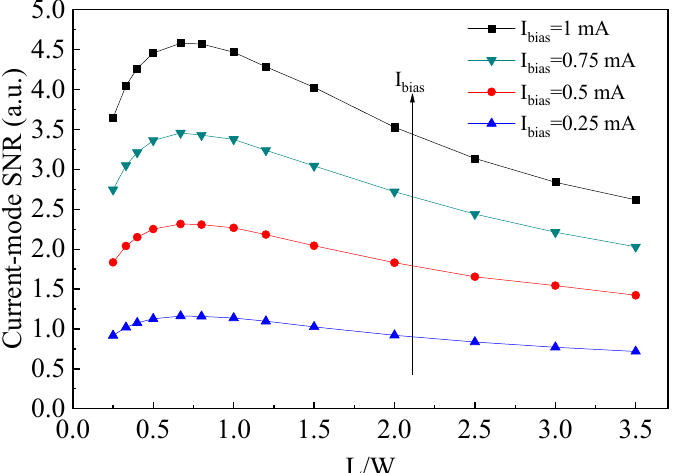
Figure 8. Simulated current-mode SNR varies with L / W ratio for di ff erent bias current condition under low magnetic field.